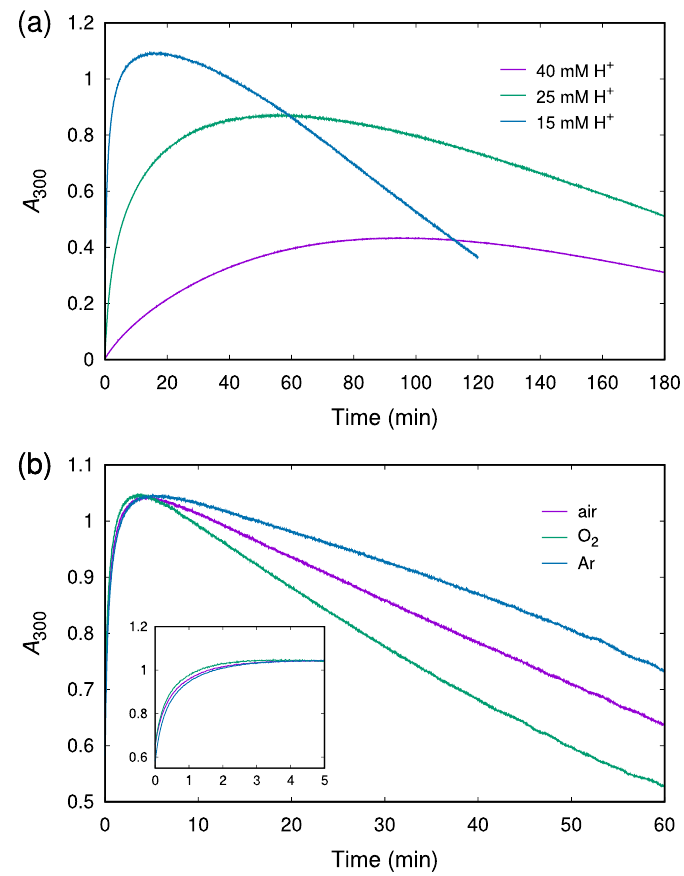
Figure 4. Time dependence of the absorbance at 300 nm of Cu–NAC mixtures ( a ) in various solutions of HClO 4 and ( b ) in a 10 mM HClO 4 solution (air) compared with solutions bubbled for 5 min by oxygen and argon before the reaction started. Initial concentrations: 300 µ M Cu 2+ , 300 µ M NAC. The records were acquired on the diode array spectrophotometer (shutter off) at 20 ◦